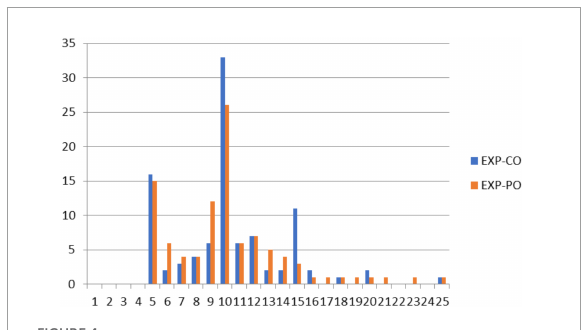
FIGURE4 Percentage of endorsement for total scores for EXP-CO and EXP-PO. Nodes at 5 and 10 for total scores indicate a high proportion of respondents chose response options “1” or “2” for EXP-CO and EXP-PO. EXP-CO is the counselor–expectations scale, while EXP-PO refers to the parole officer–expectations scale.